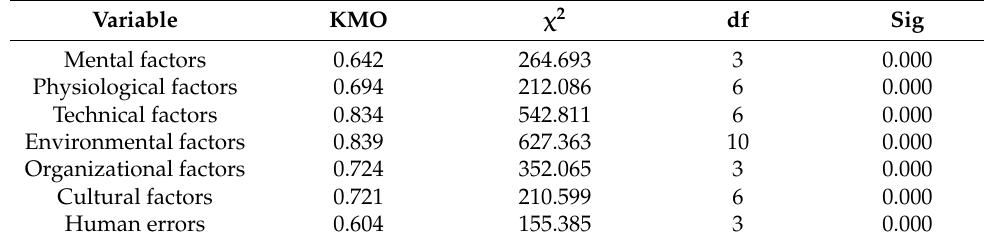
Table 4. KMO and Bartlett test sphericity test results.